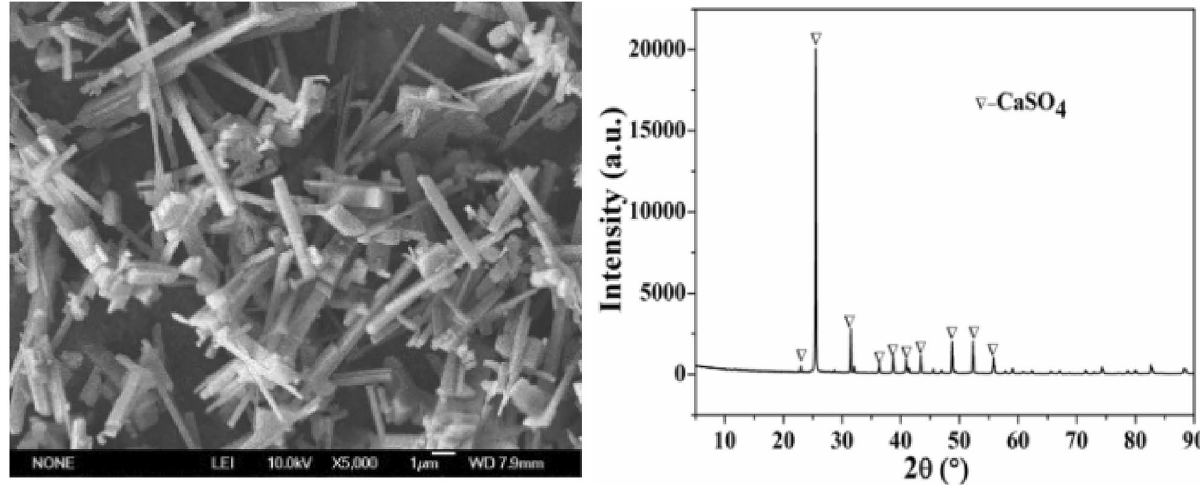
Figure 5. A SEM photograph and the XRD pattern of PPG.